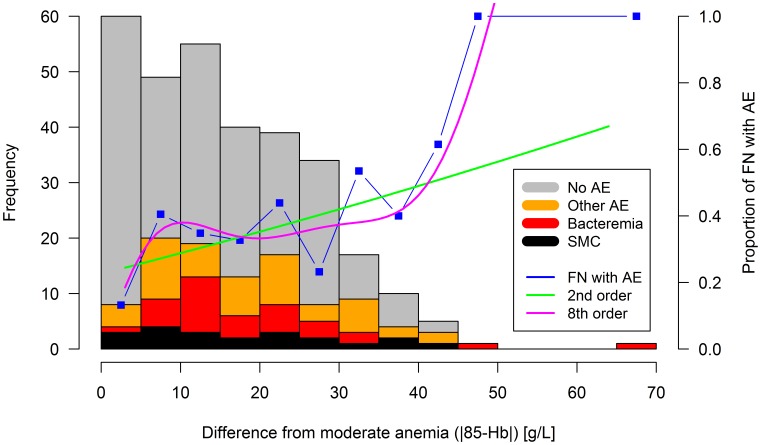
Adverse events versus the difference from moderate anemia.Frequency histogram of FN episodes (left vertical axis). Proportions of FN episodes with any AE measured, and by 2nd and 8th order regression smoothing (right vertical axis).